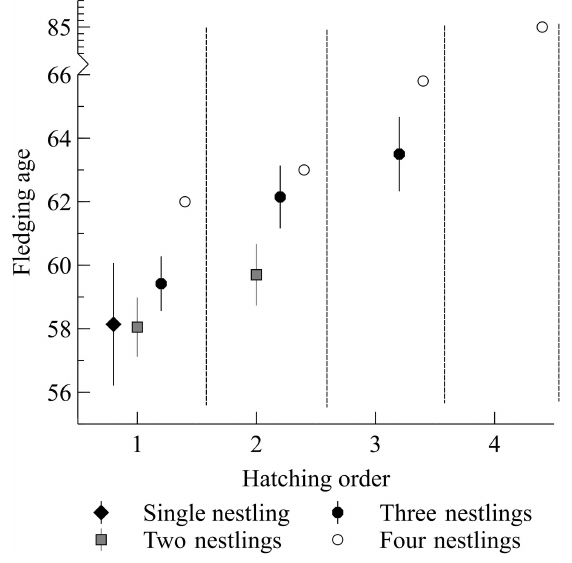
Fig. 5 . Rearing period length (mean ± SE) as a function of hatching order of nestlings of Turquoise-fronted Parrot ( Amazona aestiva ) at Loro Hablador Provincial Park in northern